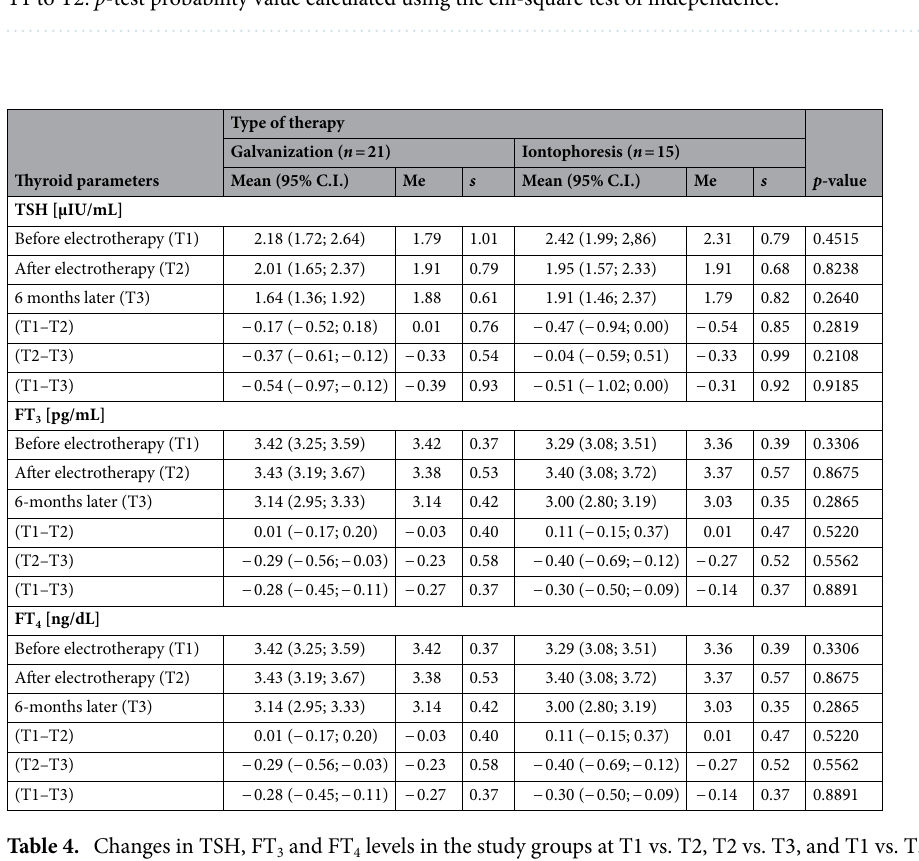
Table 4. Changes in TSH, FT 3 and FT 4 levels in the study groups at T1 vs. T2, T2 vs. T3, and T1 vs. T3. p -test probability value calculated using the independent samples t -test.